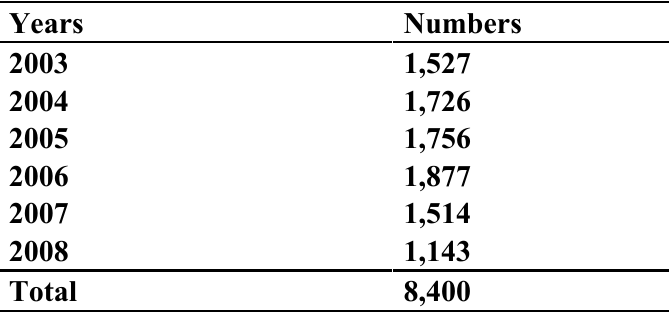
Table 2. Number of Non Compliance Wells